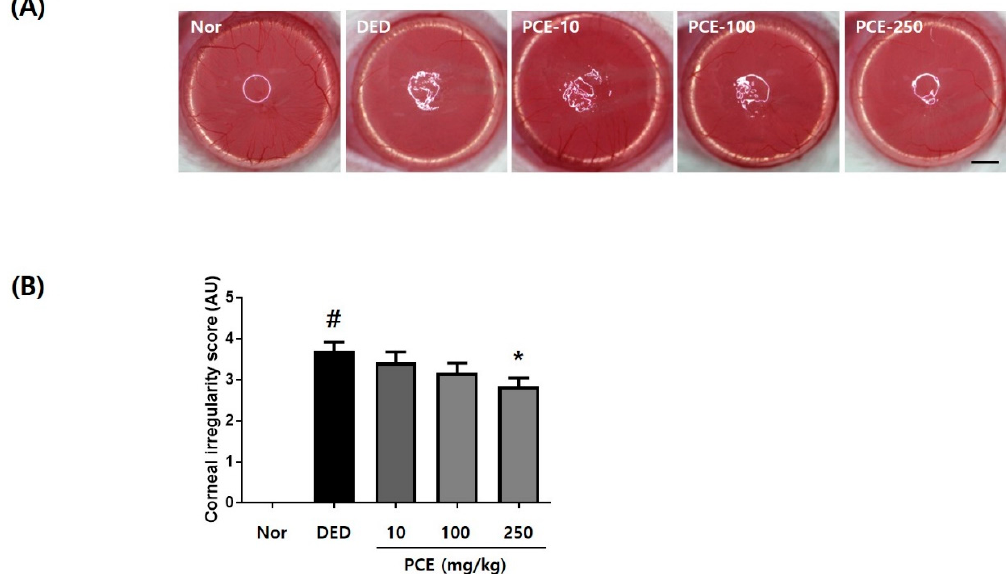
Figure 3. Effects of P. cuspidatum (PCE) on corneal surface irregularities in exorbital lacrimal gland-excised rats. ( A ) Reflected images of a white ring from the fiber-optic ring illuminator of a stereomicroscope. Scale bar is 1 mm. ( B ) Corneal irregularity was graded according to the number of distorted quarters in the reflected white ring as follows: 0, no distortion; 1, distortion in one quarter; 2, distortion in two quarters; 3, distortion in three quarters; 4, distortion in all four quarters; 5, severe distortion, in which no ring could be recognized. The values in the bar graph represent the mean ± SEM, n = 10. # p < 0.05, significantly different from normal rats, * p < 0.05, significantly different from vehicle-treated dry eye rats.